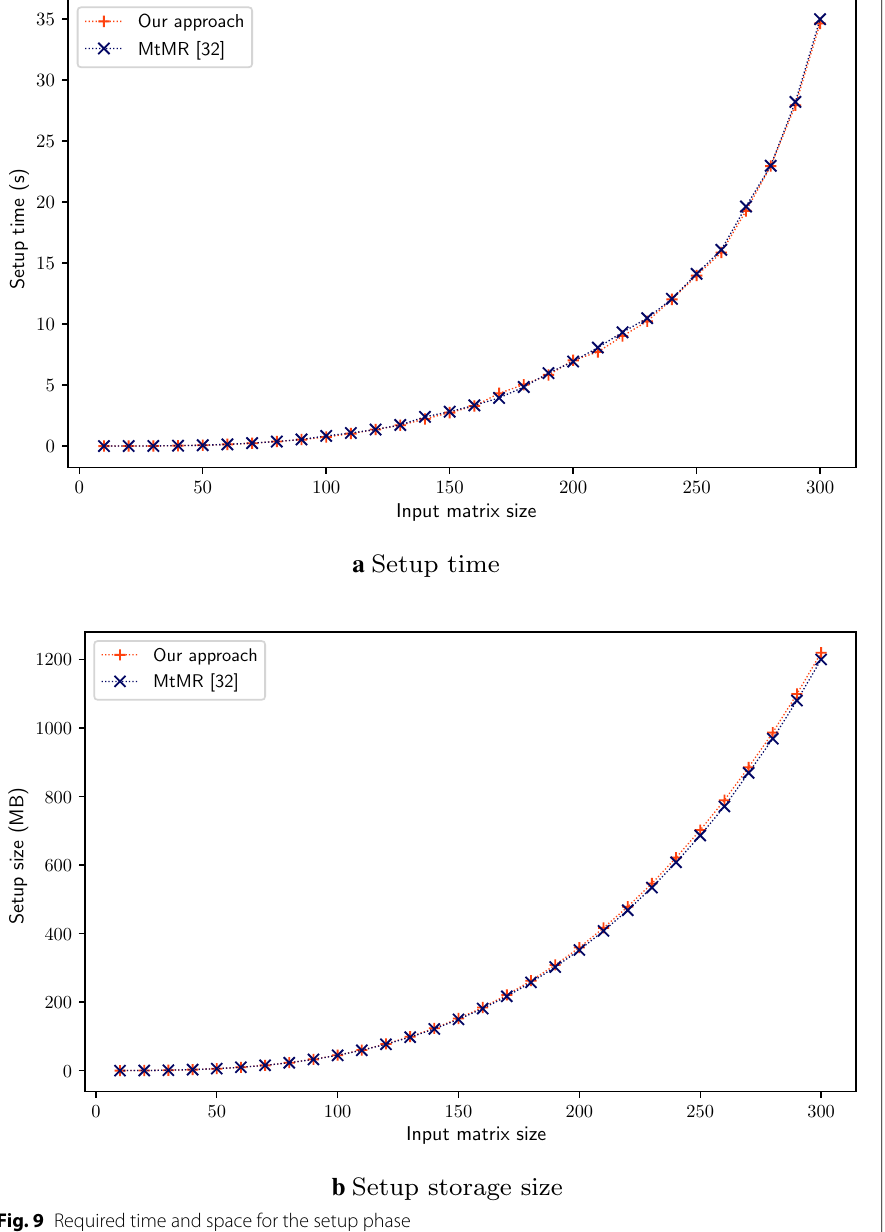
Fig. 9 Required time and space for the setup